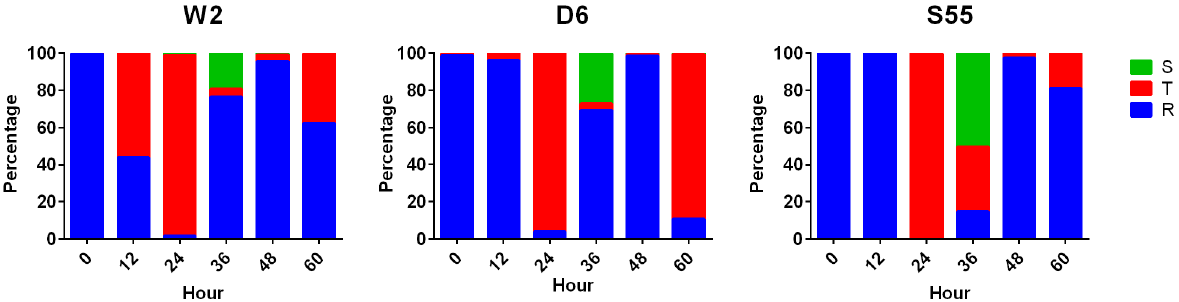
Fig 1. Percentage of life cycle stages of P . falciparum lines of W2, D6 and S55 at different time points (0, 12, 24, 36, 48 and 60 h). S, T and R represents schizont, trophozoite and ring-stages, respectively.